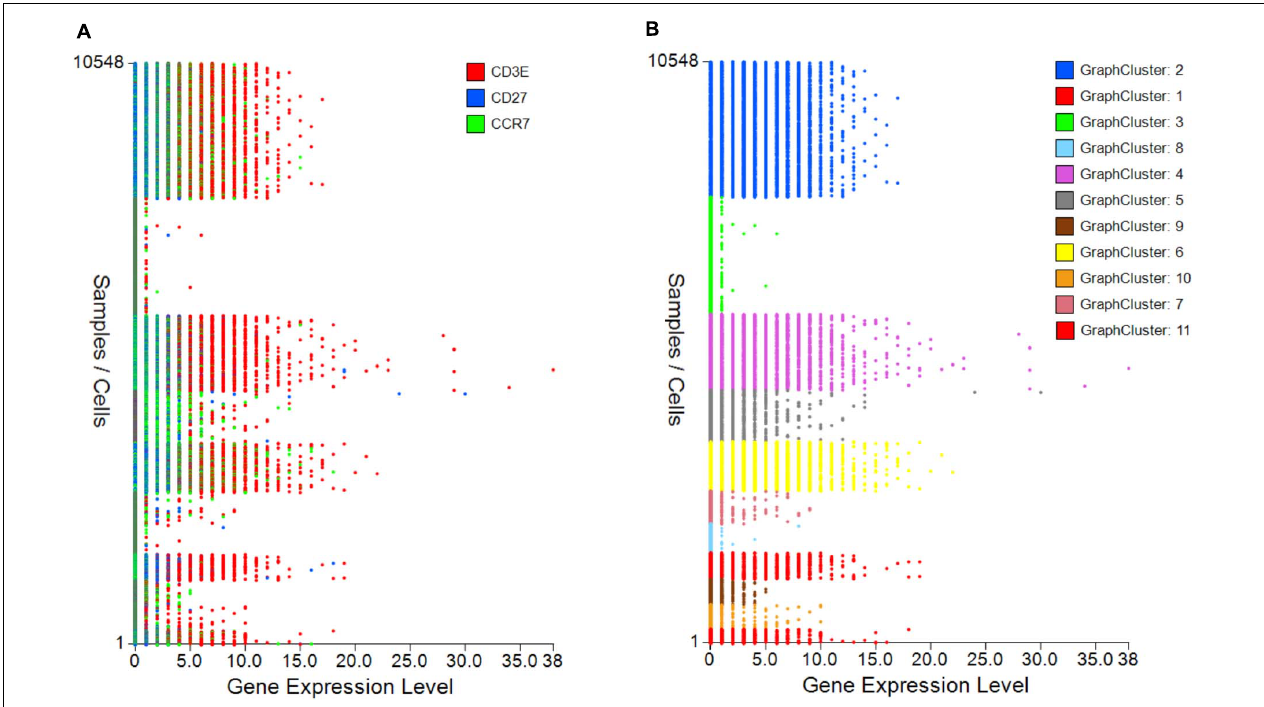
FIGURE 5 | Gene expression plots to provide cutoffs for negative/positive expression or show differences between samples/groups. (A) Single or grouped gene expression plots for all cells within a selected sample provides a platform to set cutoff for positivity and identify outlier expression or (B) highlight expression differences between